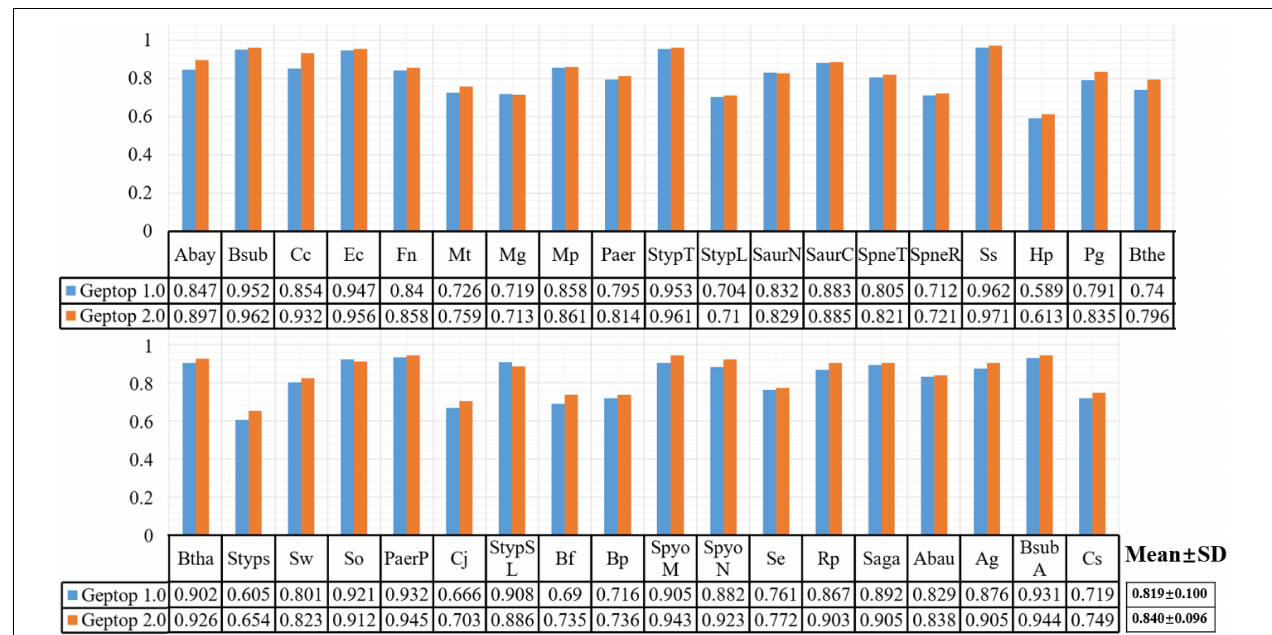
FIGURE 1 | The AUC result of 37 genomes among Geptop 1.0, Geptop 2.0. And the abbreviation of 37 bacteria please refers to Supplementary Table S1 .